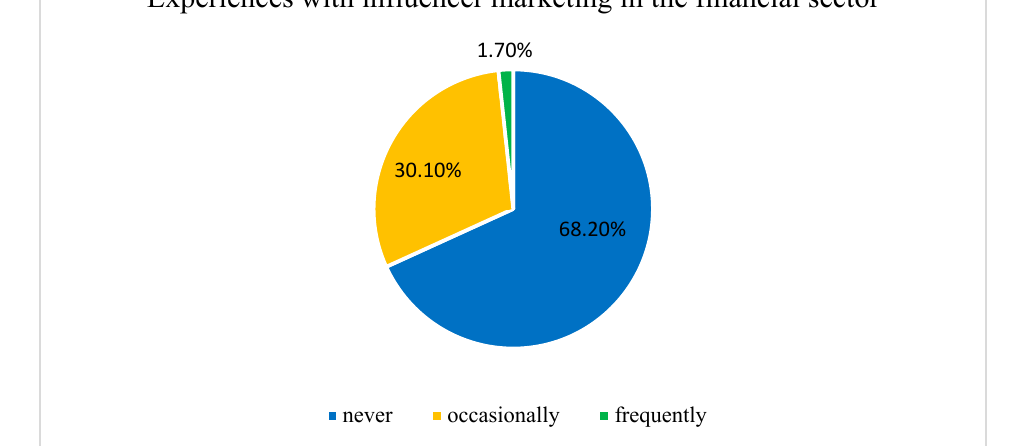
Figure 2. Experience with influencer marketing in the financial sector .